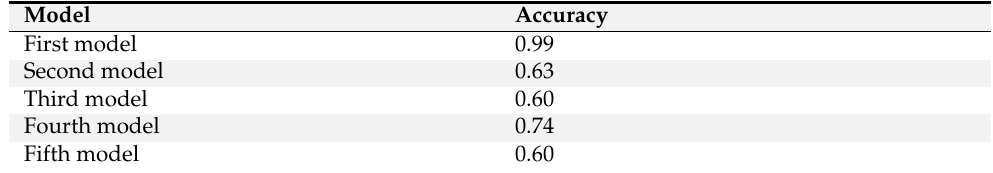
Table 6. Model accuracy.